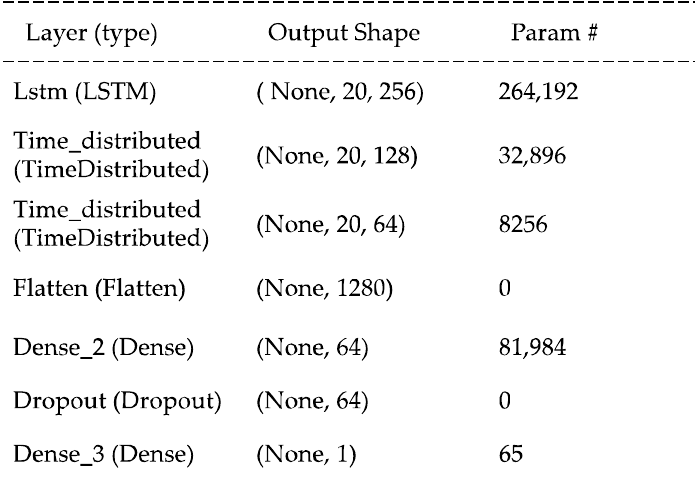
Figure 10. RvNN model architecture.